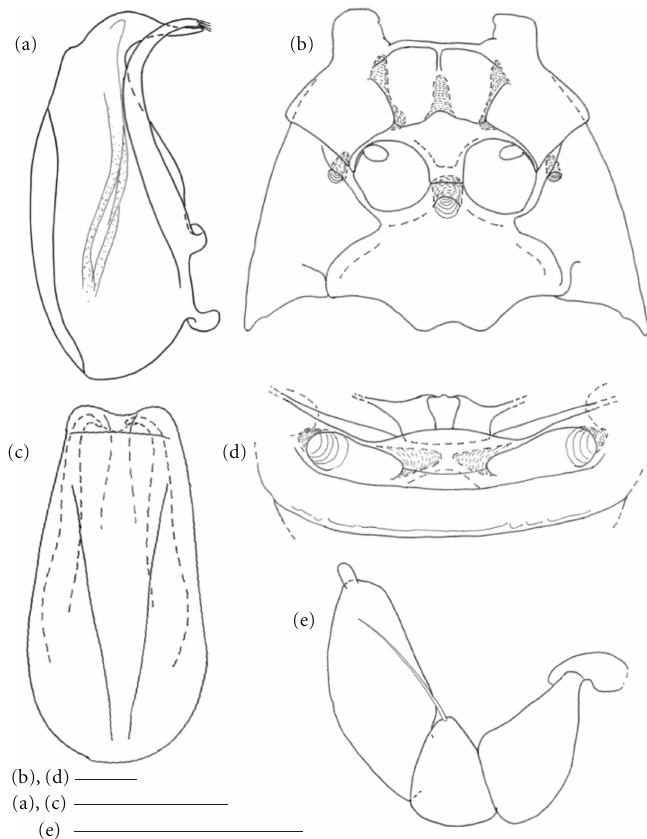
Figure 3: Paragoniastes ra ff rayi . (a) and (c): Aedeagus in lateral (a) and dorsal (c) views. (b) Mesosternum and metasternum, female, ventral view, pubescence omitted. (d): Medial area of abdominal sternites 1-2, female, ventral view, pubescence omitted. (e) Left maxillary palpus, female, dorsal view. Scale bars: 0.1